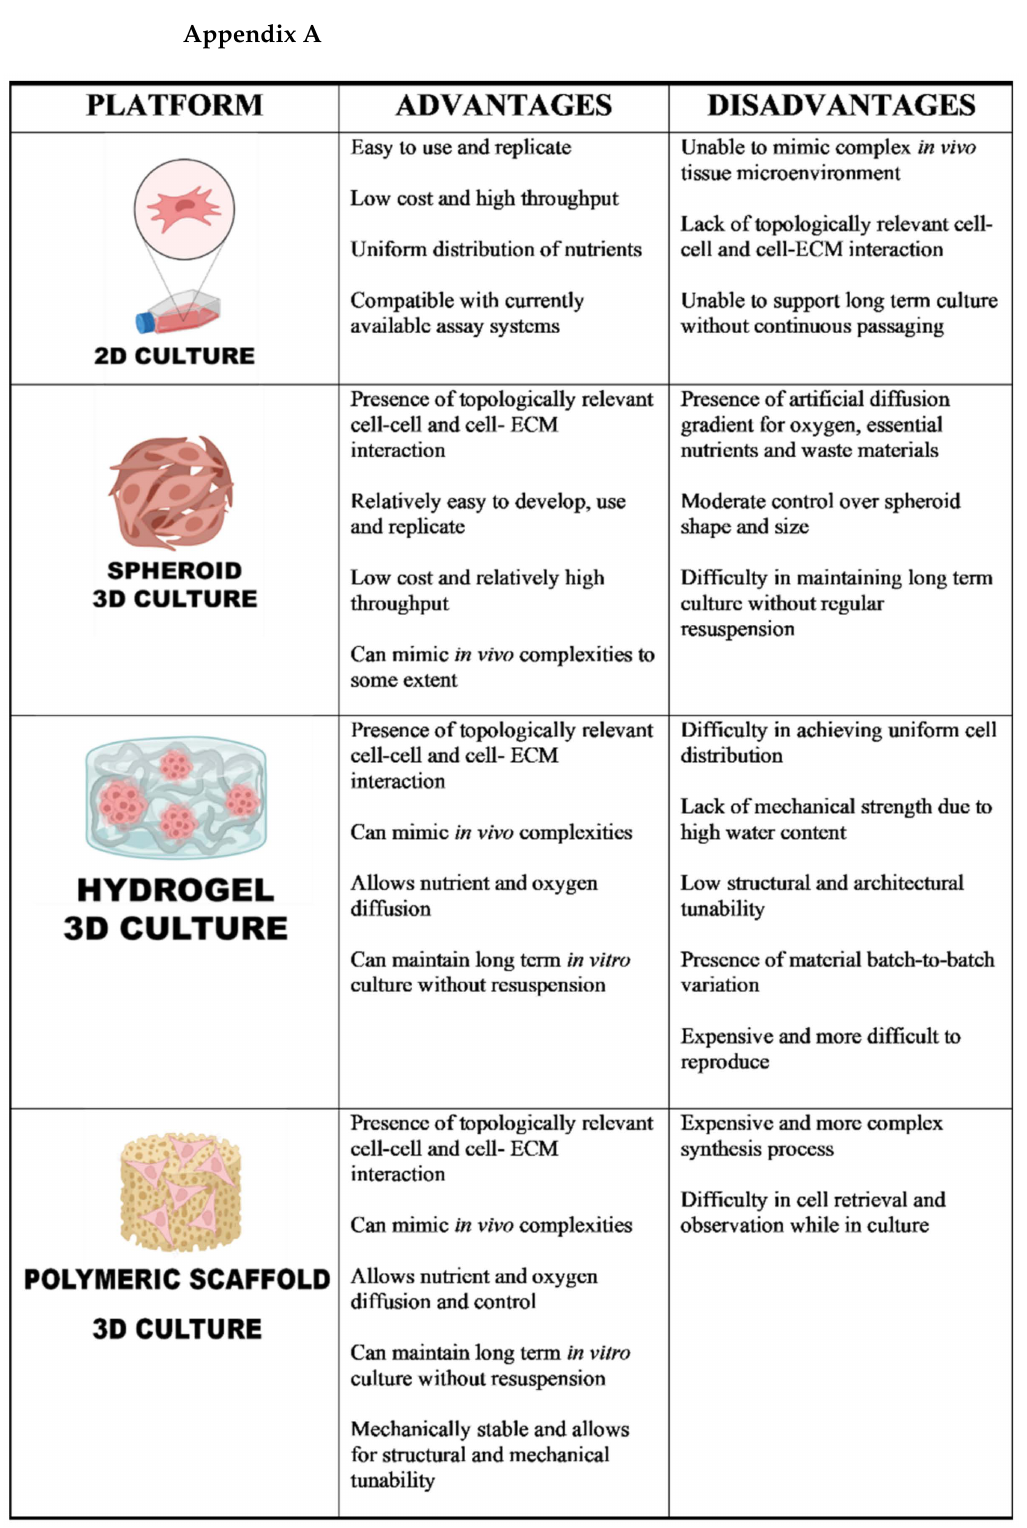
Figure A1. A graphical schematic of key techniques used for creation of OvCa tumour models (created on BioRender.com (accessed on 26 July